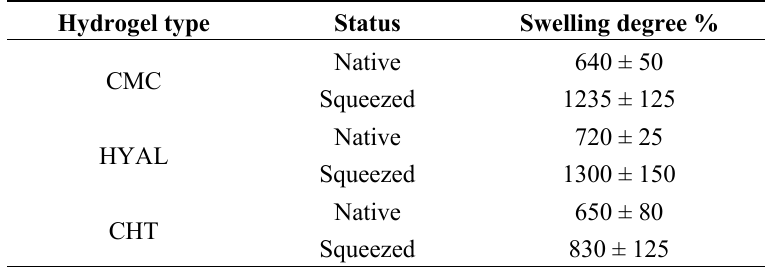
Table 2. Swelling degree of native and squeezed hydrogels in NaCl 0.1 M solution. The reported data represent the average of three samples ± standard